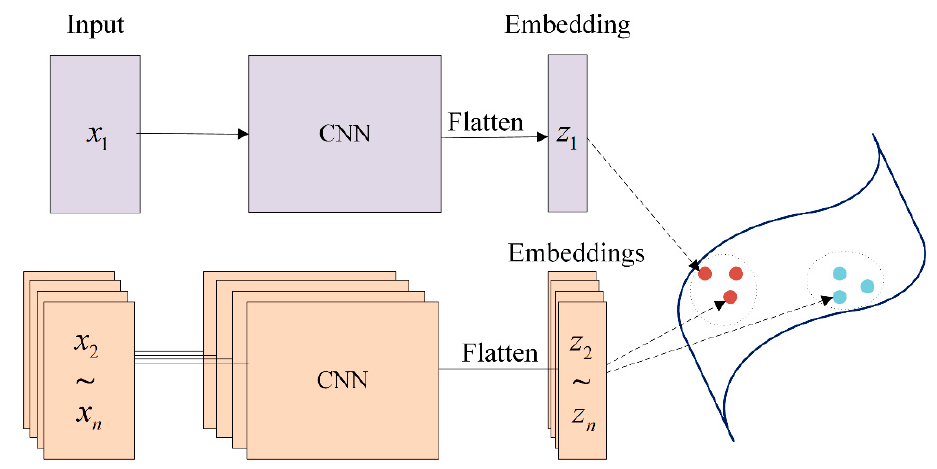
Figure 7. Siamese network for embedding the feature maps into a constant vector.